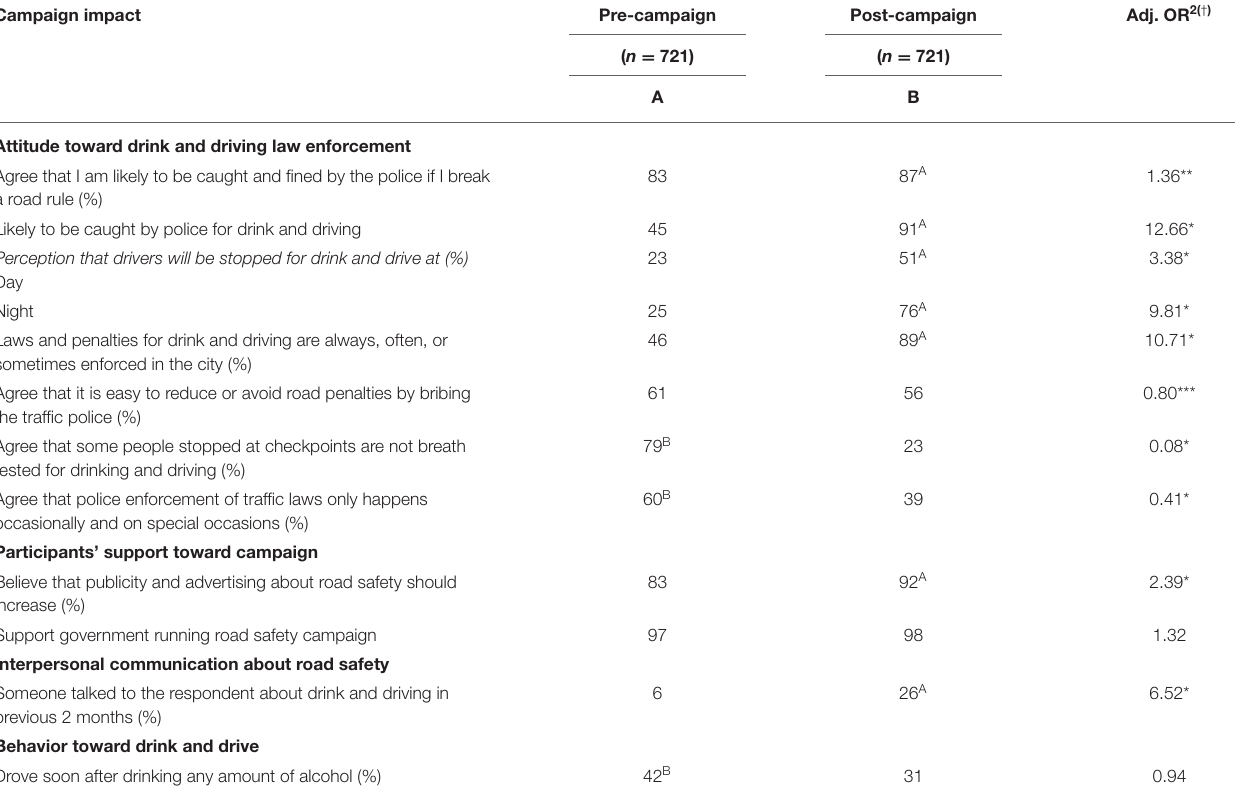
TABLE 4B | Campaign impact on risk perception, interpersonal communication, support for government action, and behavior, by pre-campaign and post-campaign period. Campaign